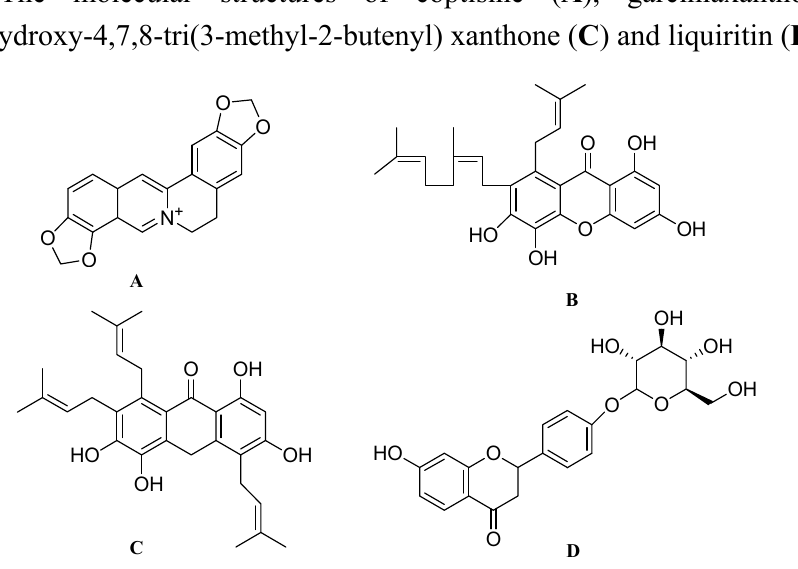
5. The molecular structures of coptisine ( A ), garciniaxanthone-E ( B